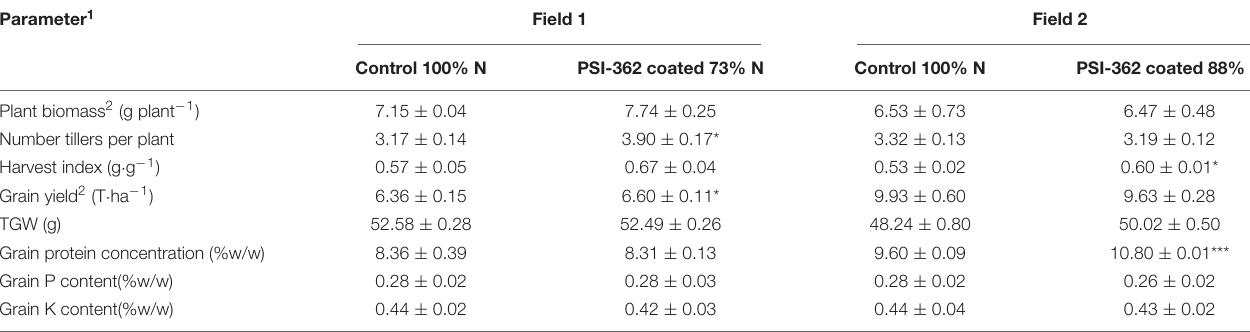
TABLE 3 | Effect of PSI-362 coated CAN + S fertilizer on plant and grain derived parameters in barley crop (cv. Gangway) at harvest.